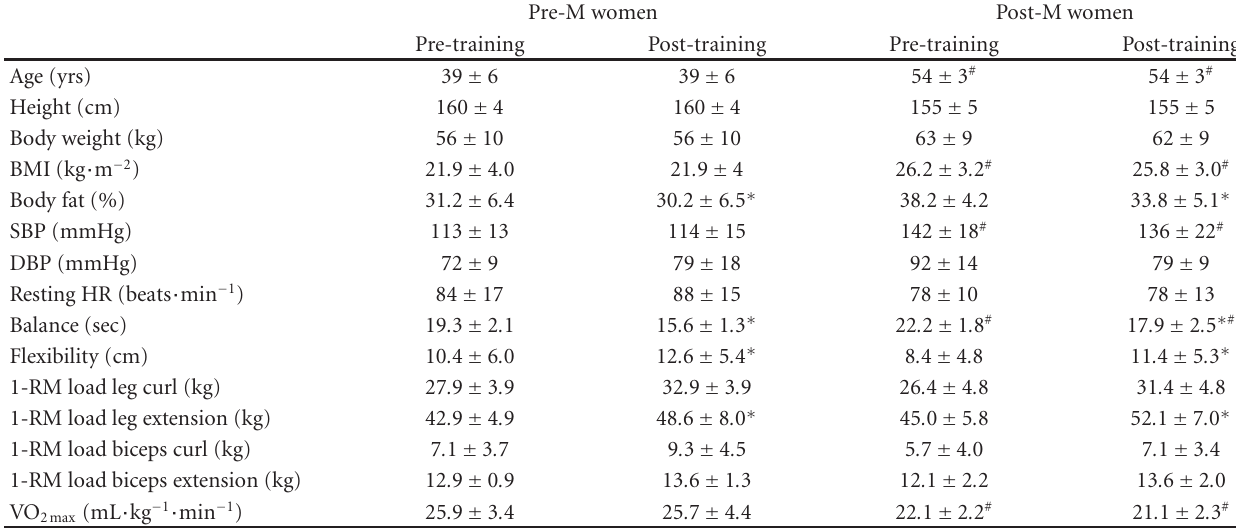
Table 1: Characteristics of pre- and post-menopausal women before and after the Tai Chi training